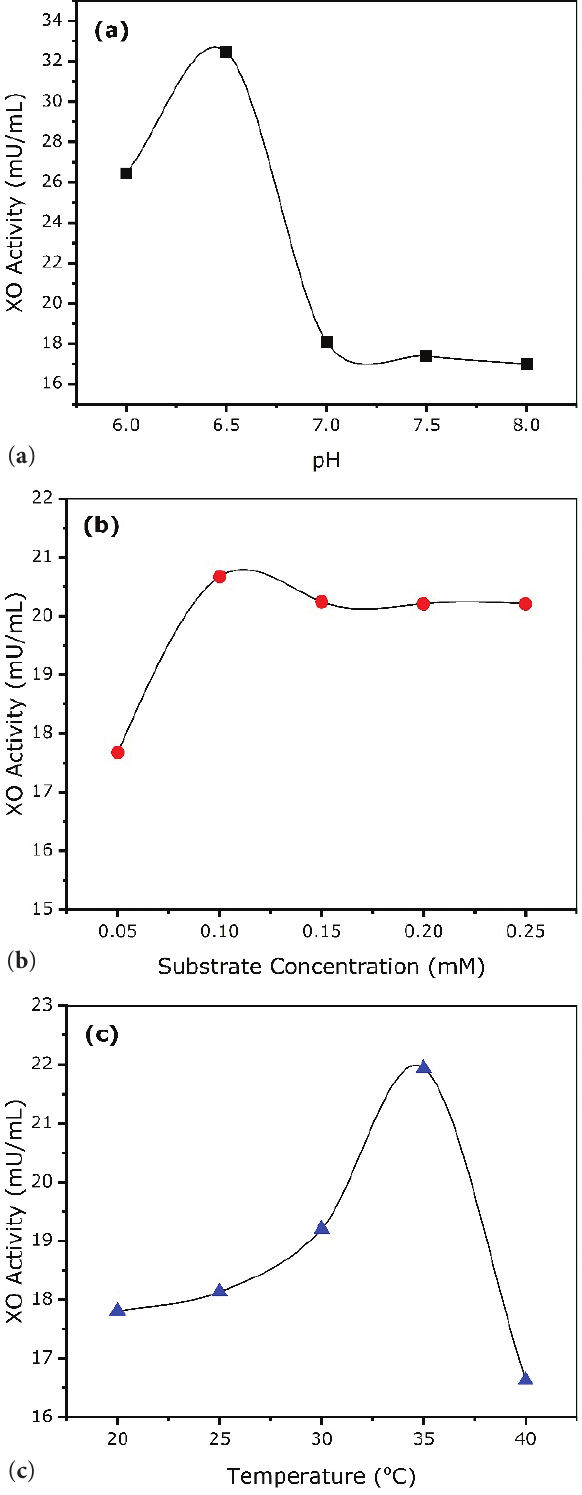
Figure 3. Characterization of XO ( a ) pH; ( b ) Substrate concen- tration; ( c )